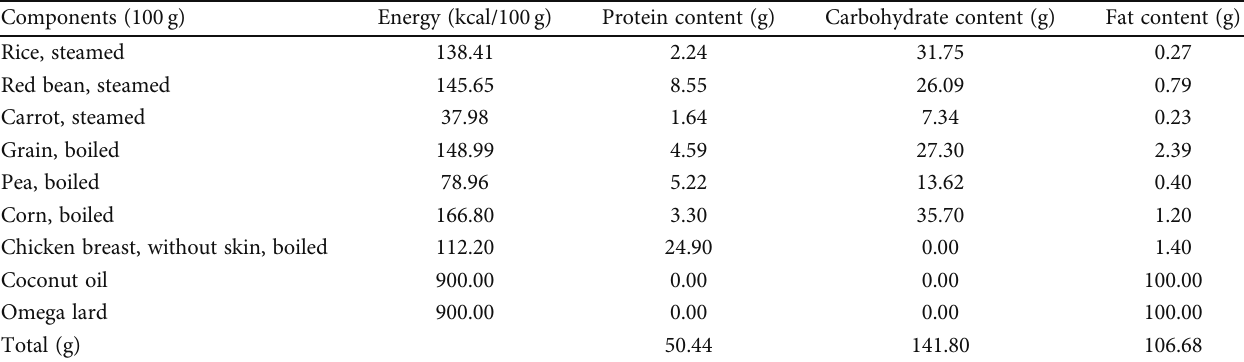
Table 4: The protein, carbohydrate, and fat content of ingredients used for coconut oil diet and omega lard diet with the total energy of